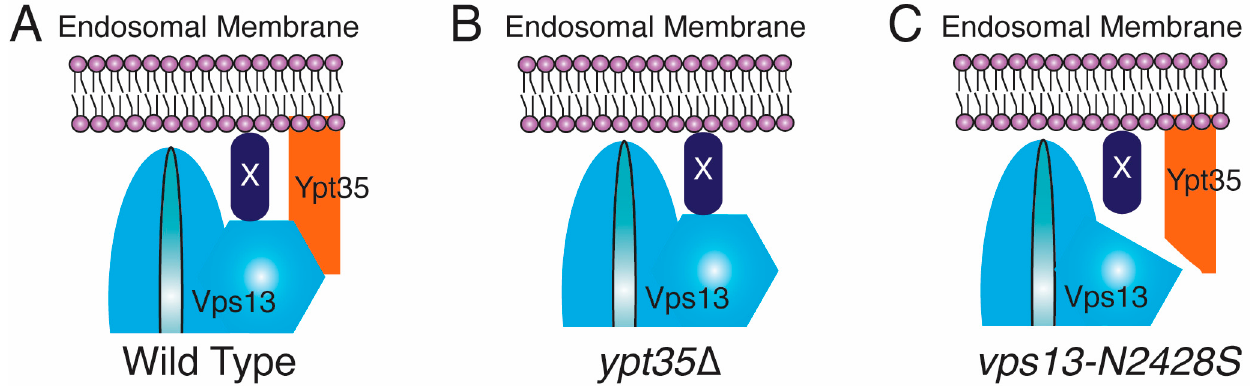
Figure 7. Two-adaptor model for Vps13 binding to the endosome. ( A ) In wild-type cells, Vps13 is stably recruited to the endosome by a strong interaction with Ypt35 and a weak interaction with a second, hypothetical protein. Both proteins interact with the Vps13 VAB domain. Interaction with X is required for proper CPY sorting. ( B ) In ypt35 ∆ cells, only the weak interaction is present. This is sufficient for CPY sorting but not for a stable localization to the endosome. ( C ) In vps13-2428S cells, both interactions are disrupted and both localization and CPY sorting are lost.